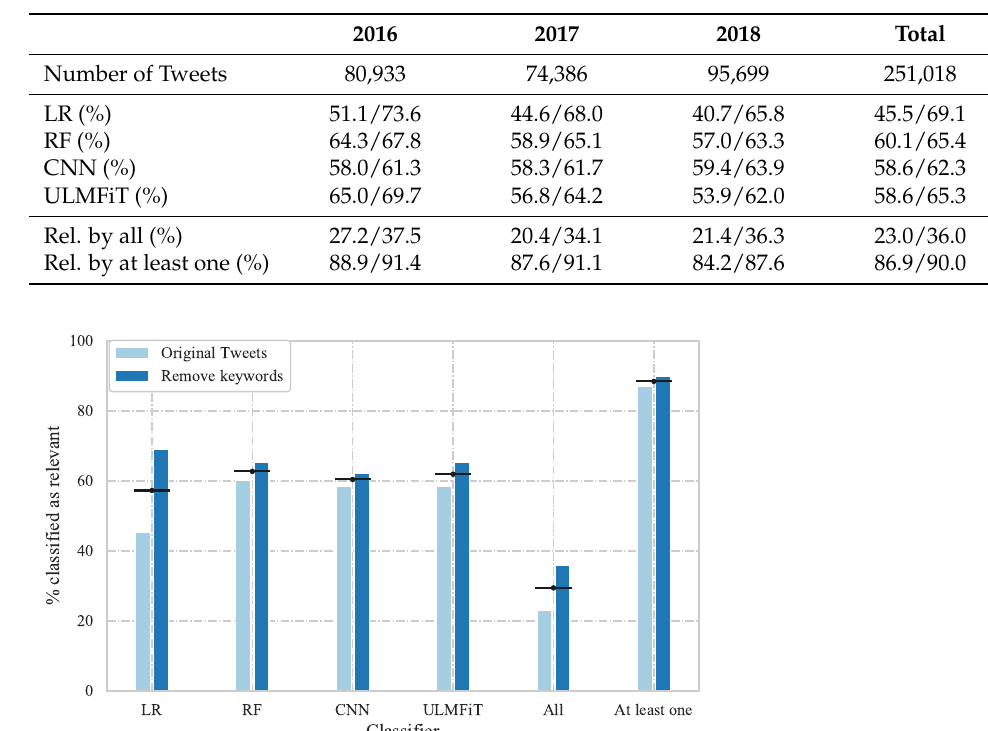
Table 3. Number of tweets and the percentages of tweets classified as relevant by each classifier, by all classifiers, and by at least one classifier from 2016–2018, and in total for the original tweets and remove keywords separated with a forward slash.